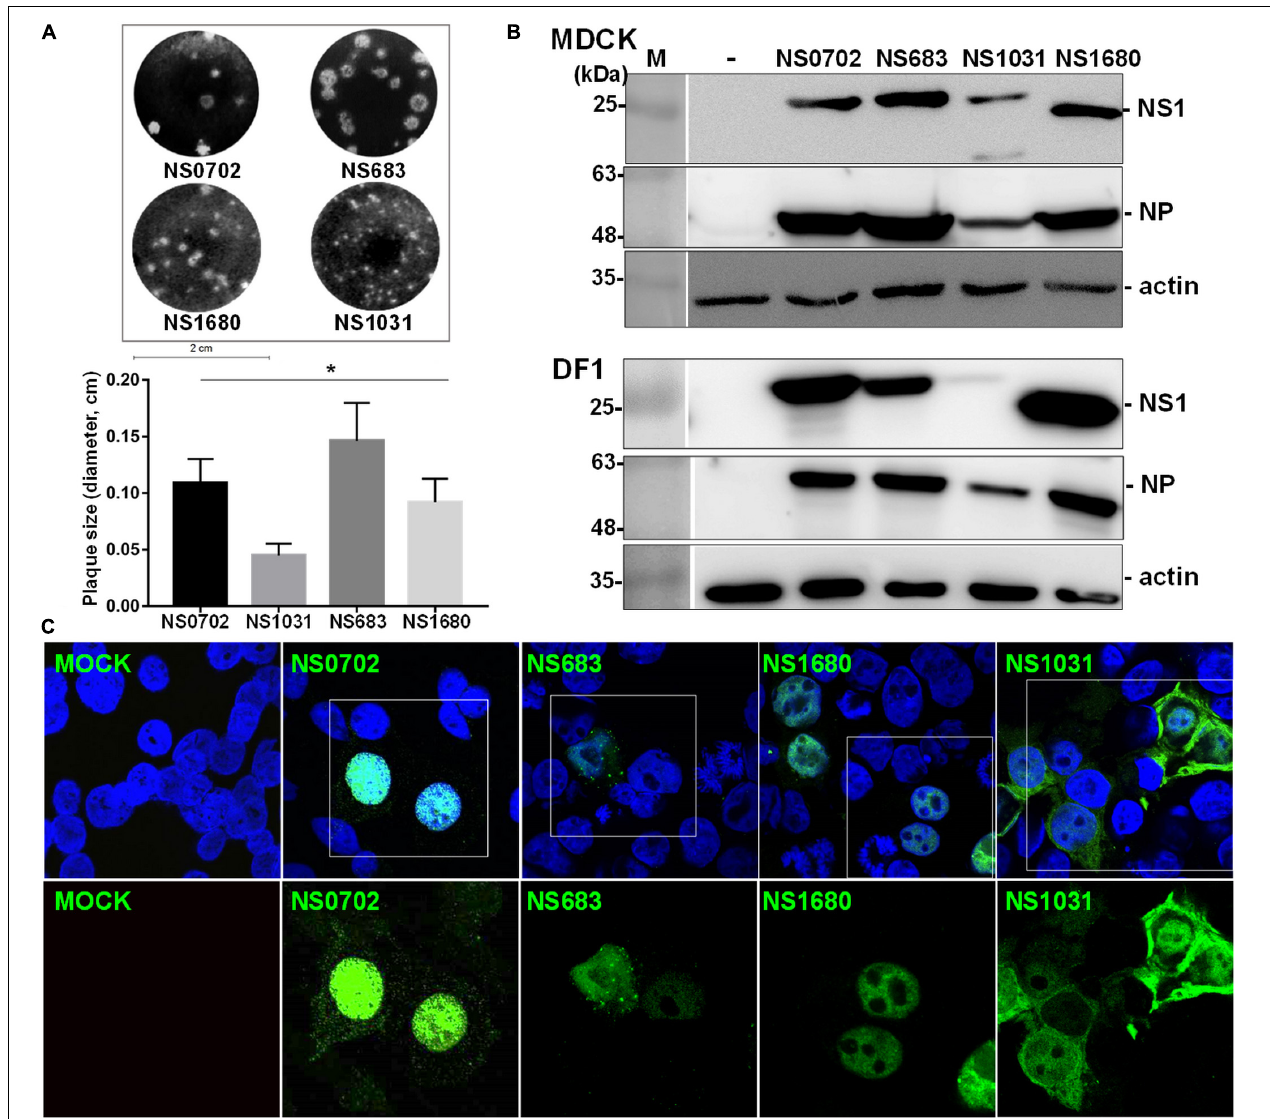
FIGURE 2 | Characterization of recombinant avian influenza virus (AIVs). Four recombinant AIVs engineered by reverse genetics (RG-AIVs) containing eight gene segments from H6N1 (NS0702) or with substitution of the NS gene derived from other H5N2 viruses (NS683, NS1680, and NS1031) were rescued. (A) Plaque formation ability and average plaque size were indicated. (B) The expression level of NS1 and NP in mock (-) or infected Madin–Darby canine kidney (MDCK) or DF-1 cells was analyzed by Western blot. (C) Cellular distribution of NS1-eGFP enhanced green fluorescent protein in 293 cells was detected at 24 h after transfection by fluorescence microscopy, at 400 × magnification. The image in white boxes on the top raw was further enlarged and shown in the lower panel. Nucleus was indicated in blue by DAPI staining. * indicates significant difference ( p < 0.05) in plaque size relative to parental virus (NS0702).